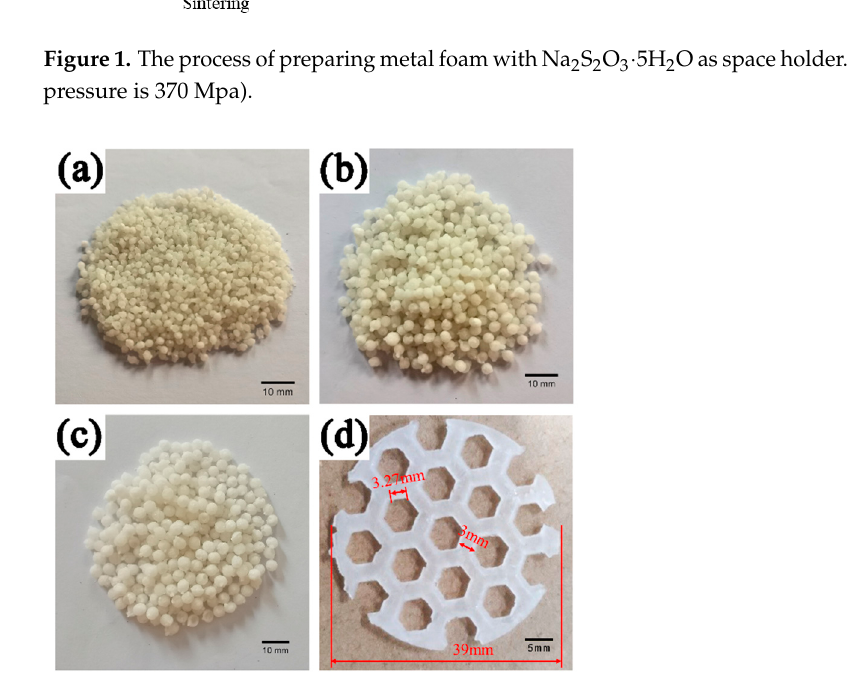
Figure 2. The space holder (( a – c ) are spherical, and the sizes are Φ 2, Φ 3 and Φ 4 mm, respectively, and ( d ) is the hexagonal channel).